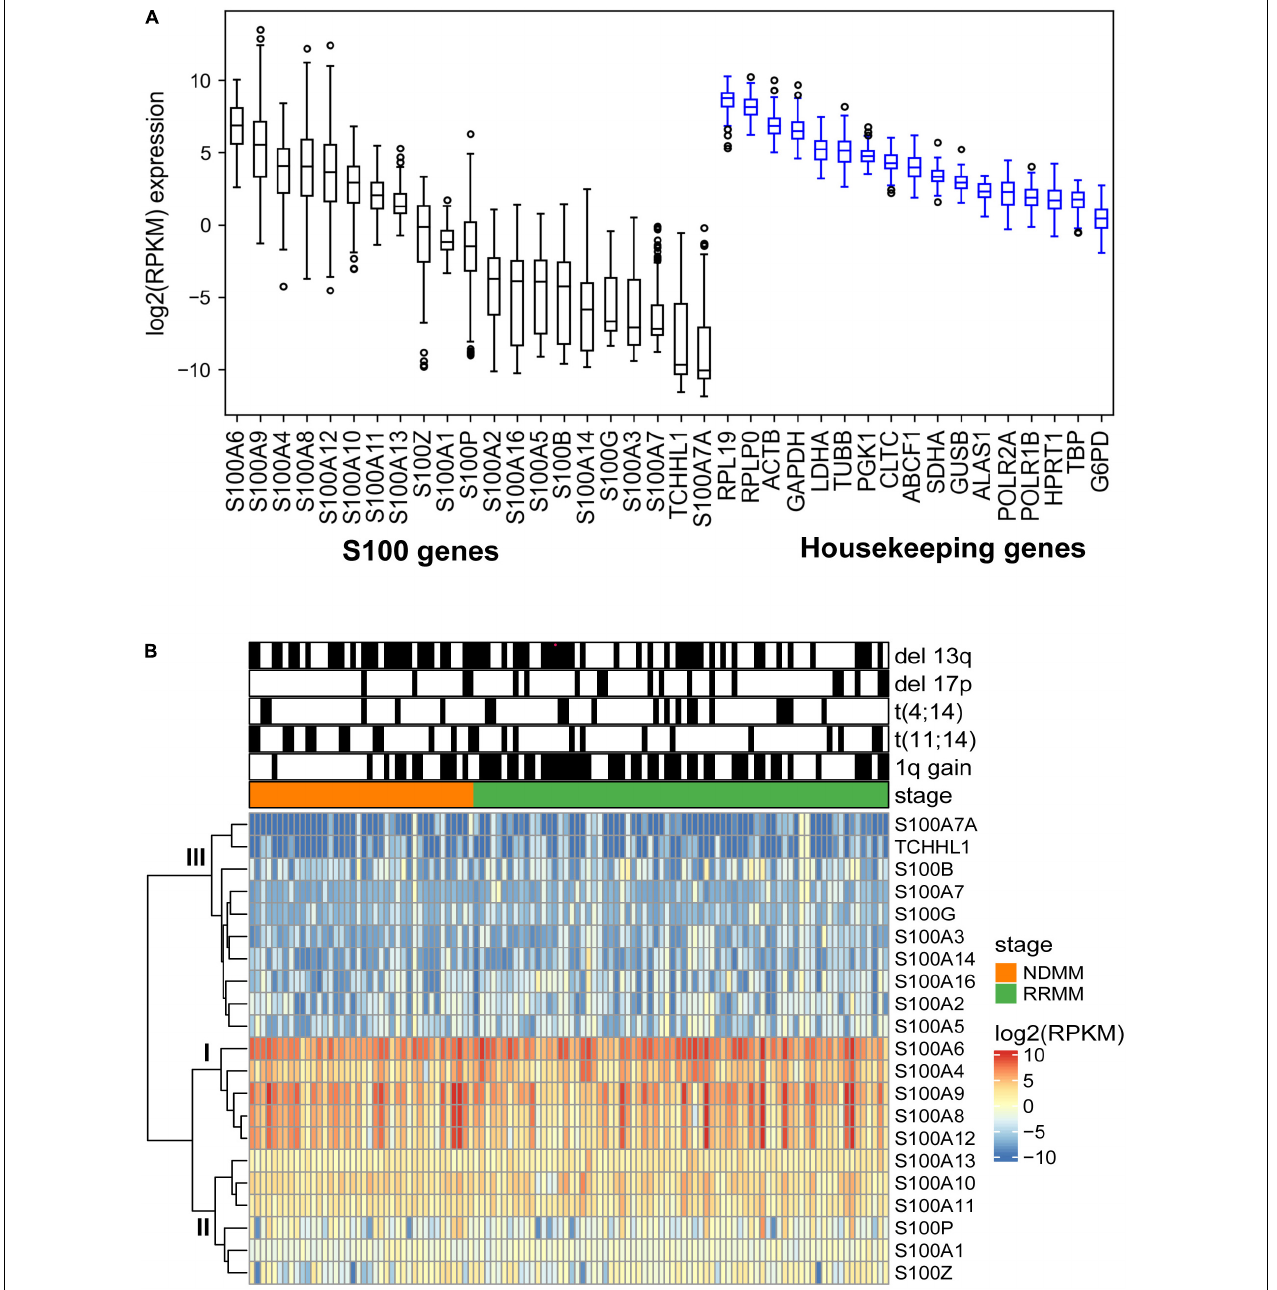
FIGURE 2 | Expression profile of S100 family genes in multiple myeloma samples. (A) Boxplot showing the log2 (RPKM) expression of S100 and housekeeping genes from 116 MM samples. Genes are ranked based on median expression values. (B) Hierarchical clustering of S100 genes and patient samples using Euclidean distance matrix and complete clustering